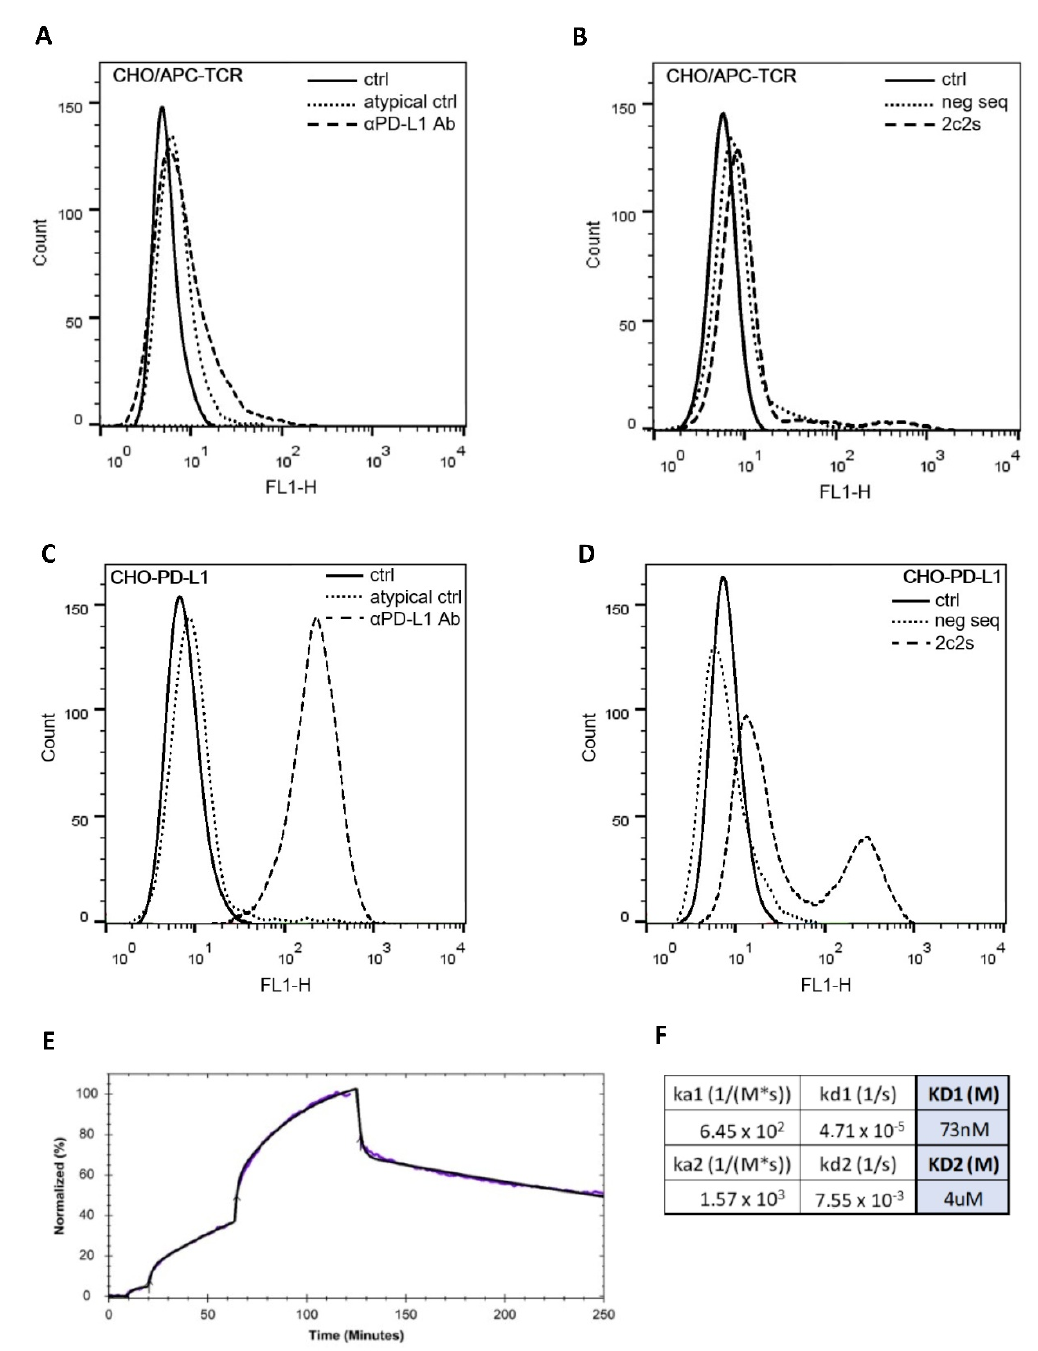
Figure 4. The 2c2s specifically labels PD ‐ L1 at the cell surface. CHO/APC ‐ TCR cells were labeled with ( A ) α‐ PD ‐ L1 mAb (clone MIH1) or ( B ) FAM conjugated 2c2s, and CHO ‐ PDL1 cells (overexpressing PD ‐ L1) were labeled with ( C ) α‐ PD ‐ L1 mAb (clone MIH1) or ( D ) FAM conjugated 2c2s, and evaluated by flow cytometry. Isotype antibody and scrambled aptamer served as controls, respectively. ( E ) Ligand Tracer binding traces. Model fit to experimental data suggests two interaction sites with parameters given in panel ( F ).